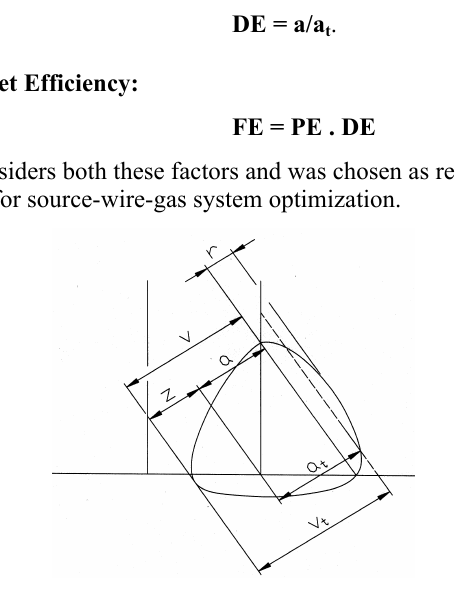
Fig. 10. Measured and calculated values